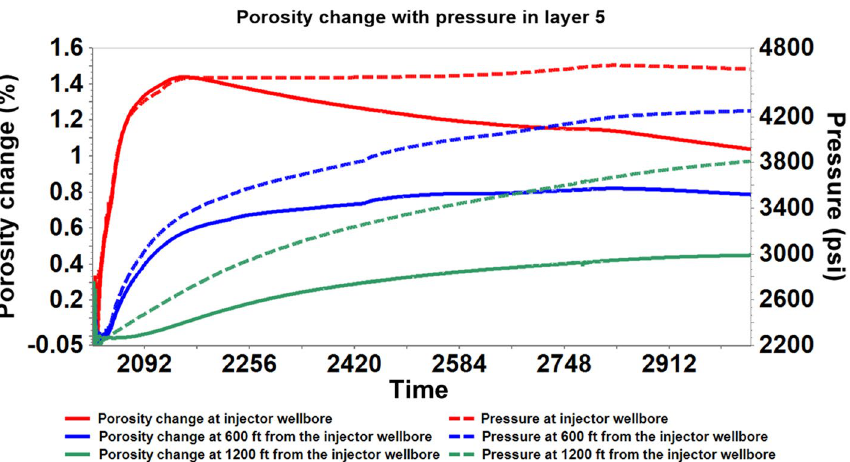
Figure 12. The evolution of stress-induced porosity changes with pressure within the bottom caprock layer (Layer 5) at variable distances from the wellbore during 1000 years of